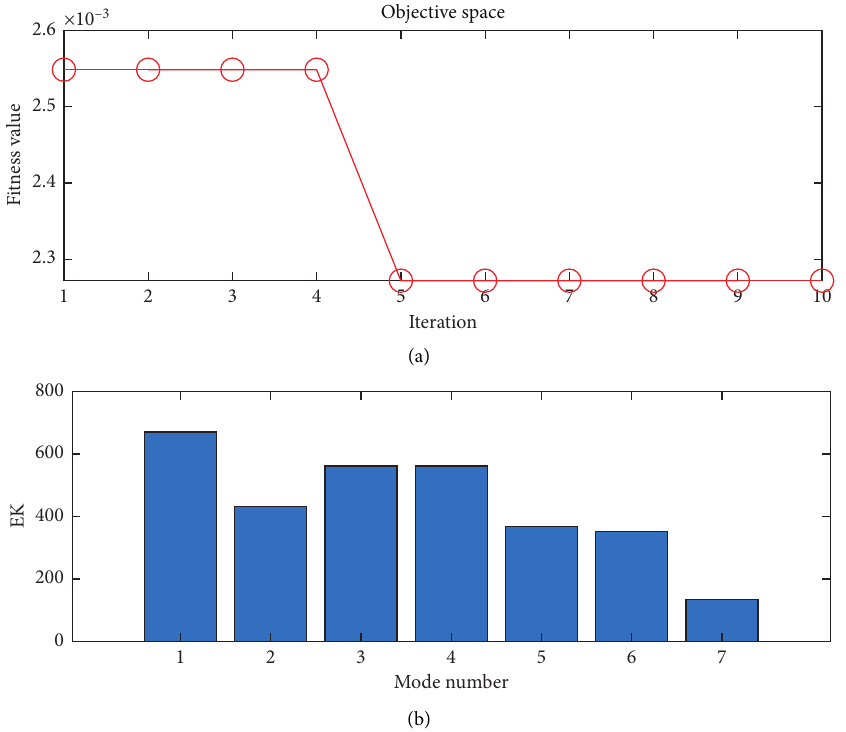
Figure 22: Experimental signals of case 1: the optimization process based on PAVMD: (a) PSO convergence curve and (b) the EK value of each component.